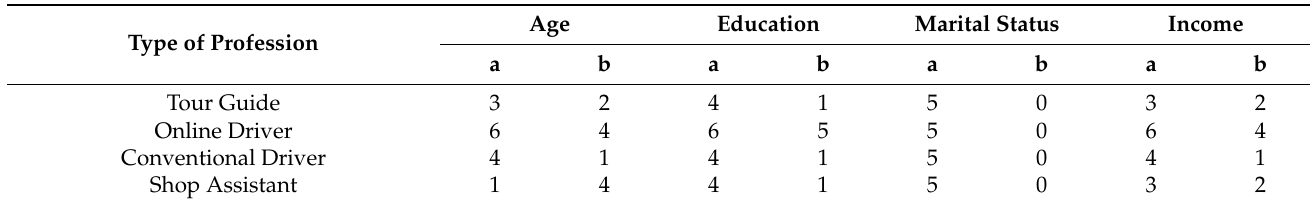
Table 1. Profile of